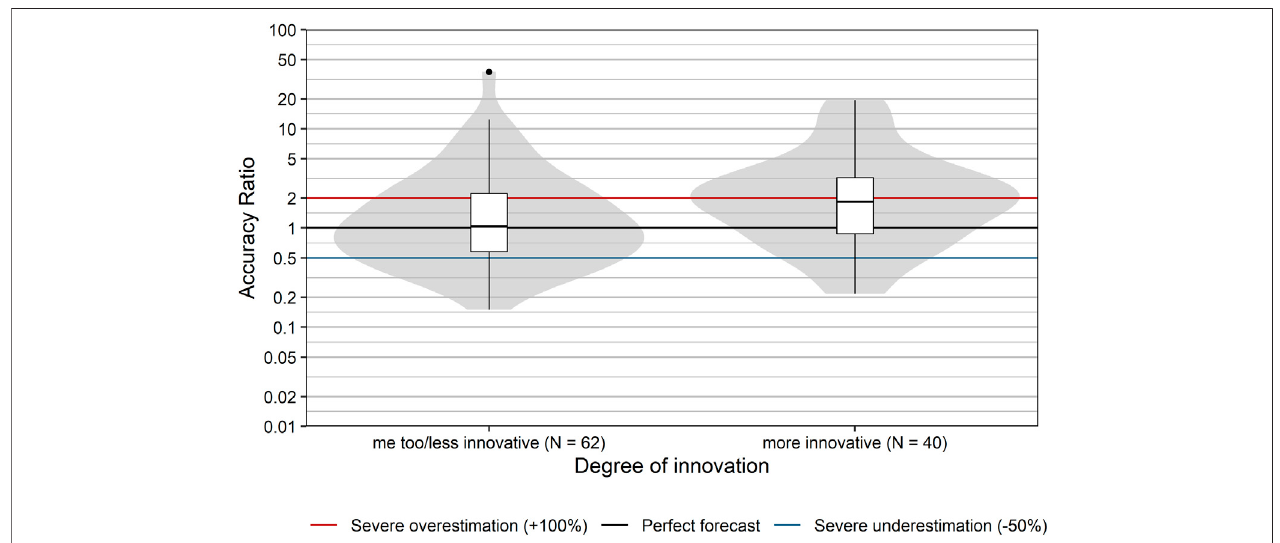
FIGURE6| Comparisonofaccuracyratiosbydegreeofinnovation.Boxplotsandviolinplotsshowaccuracyratiosofforecastedsalesinthe3 yearsafterapositive reimbursement decision, grouped by degree of innovation as assessed by DVSV. Due to their asymmetric nature, accuracy ratios are plotted on a logarithmic (base 10) scale to avoid visually overemphasizing overestimates compared to underestimates.